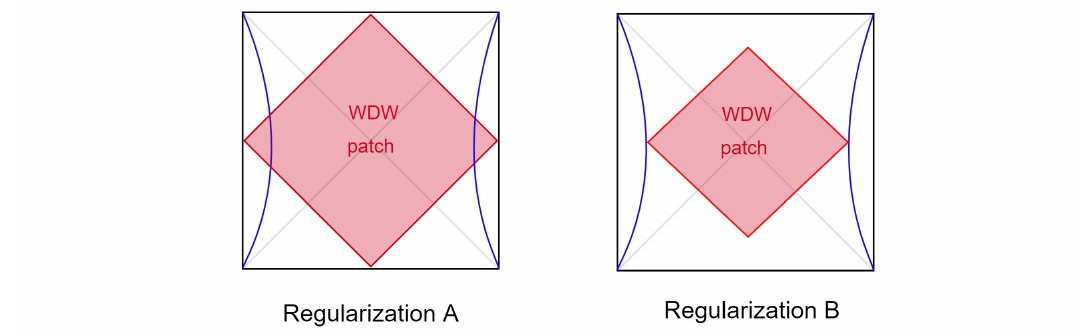
Figure 2 . The two regularizations of the WDW patch introduced in [12]. In the picture it is represented the case of a black hole in asymptotically AdS